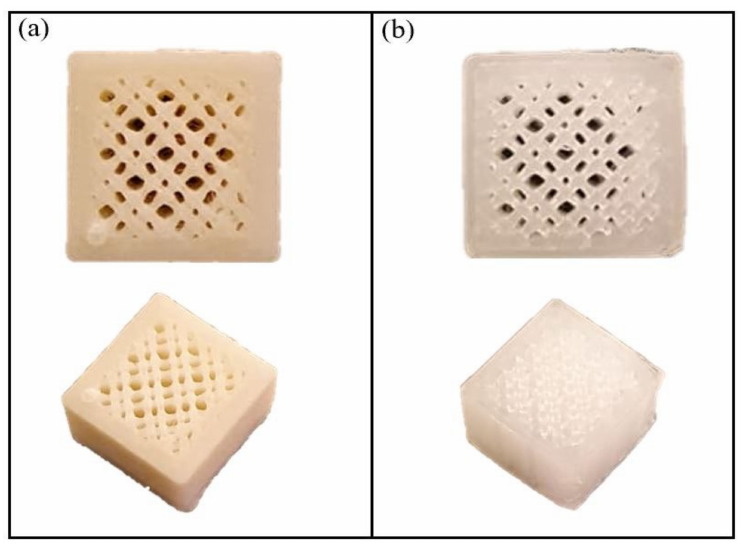
Figure 2. 3D-printed scaffold by ( a ) 9% CPO composite filament ( b ) pure natural colour